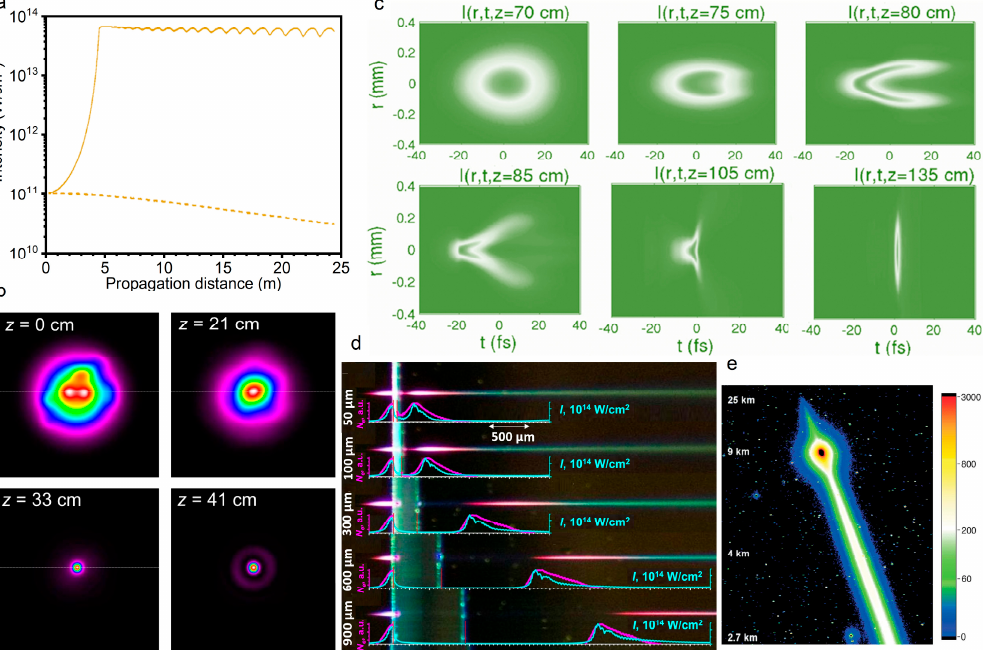
Figure 3. Exotic properties of filaments. ( a ) Self-focused intensity is clamped as a result of the generated plasma in the filament [20]. ( b ) Laser beam profiles at various propagation distances when the power is equal to three times the critical power for self-focusing in air [41]. ( c ) Pulse self-compression to the single-cycle limit by filamentation in a gas with a pressure gradient [53]. ( d ) Experimentally recorded femtosecond laser filamentation in a fused silica sample with different air gap widths. The laser pulse propagates from the left [61]. ( e ) Typical image of kilometer-range filamentation taken with the CCD camera of the Tautenburg observatory at fundamental wavelength and 1 s exposure time [63].